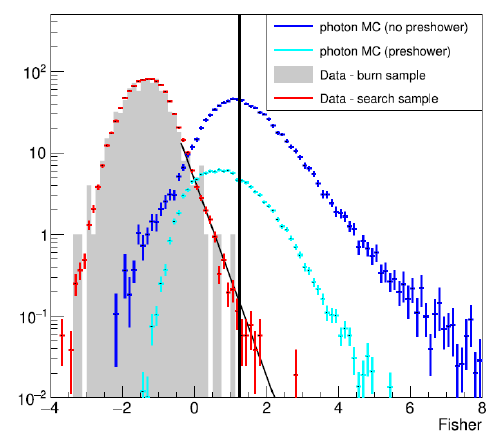
Figure 2. Distributions of the Fisher discriminant values of a set of simulated photon events (blue) and data events (red) with pho- ton energies above 10 19 eV recorded by the SD. See text and [8] for further